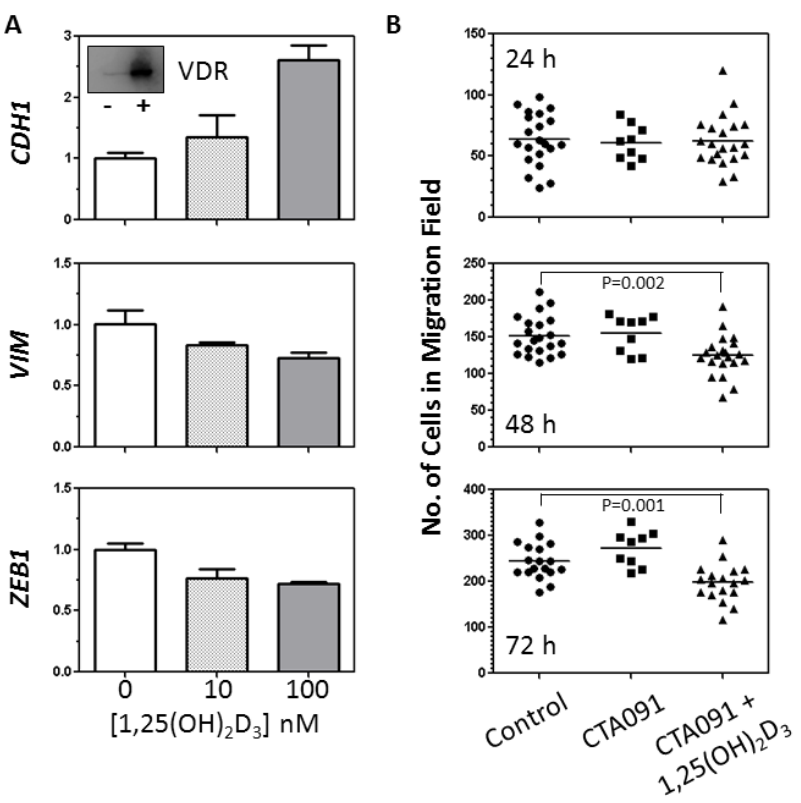
Figure 2. 1,25(OH) D supports the acquisition of an epithelial phenotype in SK-LU-1 2 3 cells and significantly decreases their migration. ( A ) SK-LU-1 cells were seeded into 6-well dishes and then treated with vehicle (controls) or 1,25(OH) D . Treatments were replaced 2 3 every two days. After 96 h, RNA was extracted. qRT-PCR was used to measure expression of the epithelial marker CDH1 and the mesenchymal markers VIM and ZEB1 . Data are the mean ± SD for triplicate measurements within a single experiment. The expression of each gene was normalized to the level obtained for vehicle treated cells. Similar results were obtained in a second, independent experiment. Inset shows VDR protein expression [20 µg/lane for vehicle treated cells (−) and cells treated with 100 nM 1,25(OH) D (+)]; 2 3 ( B ) SK-LU-1 cells were seeded into ibid cell culture inserts as outlined in the Experimental Section. The next day, the inserts were removed, and cells were treated with fresh medium containing vehicle (controls), CTA091 (50 nM), or 100 nM 1,25(OH) D plus CTA091 2 3 (50 nM). The number of cells that migrated into the open field at various times post-treatment (h) was determined. Migration was measured at three locations within each well, and the data from 3 independent experiments (1−3 wells/experiment) was pooled. Each data point reflects a separate measurement, and horizontal bars indicate the mean cell number. Data were analyzed for statistical significance using an unpaired